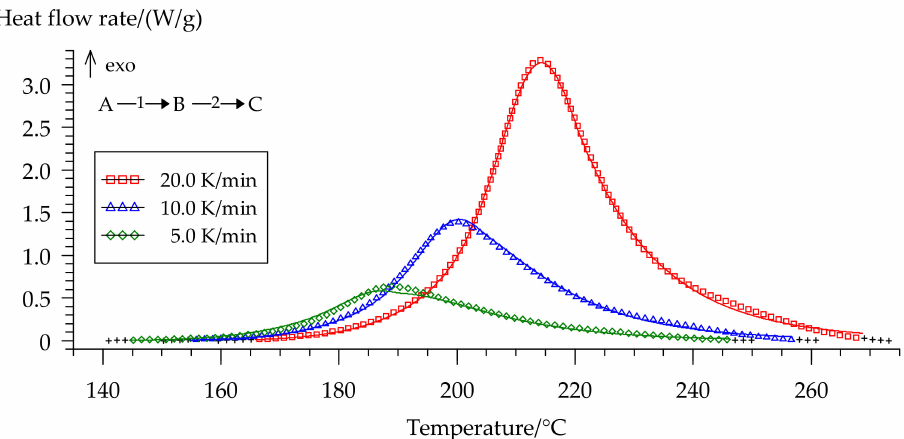
Figure 13. Comparison of experimental (symbols) and calculated (full lines) DSC curves for formulation 2: ( (cid:3) ) 20 ◦ C/min, ( ∆ ) 10 ◦ C/min, ( ♦ ) 5 ◦